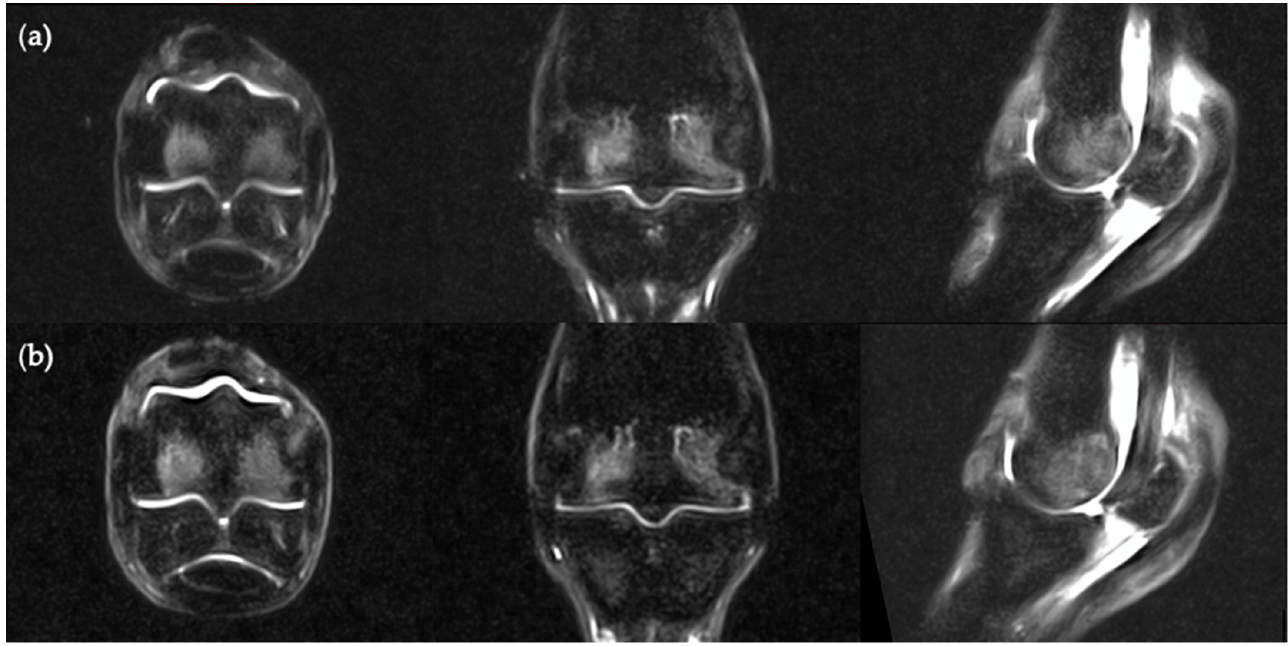
Figure 4. STIR FSE (top row) and T1W GRE (bottom row) MRI images in ( a ) transverse; ( b ) frontal and ( c ) sagittal planes; demonstrating the location of axial ROI placement in a sagittal plane. The green lines on the transverse and frontal images show the standardized orientation and location of the sagittal slice for ROI placement. The orange lines show the extent and orientation of all the sagittal slices acquired in the MRI study.